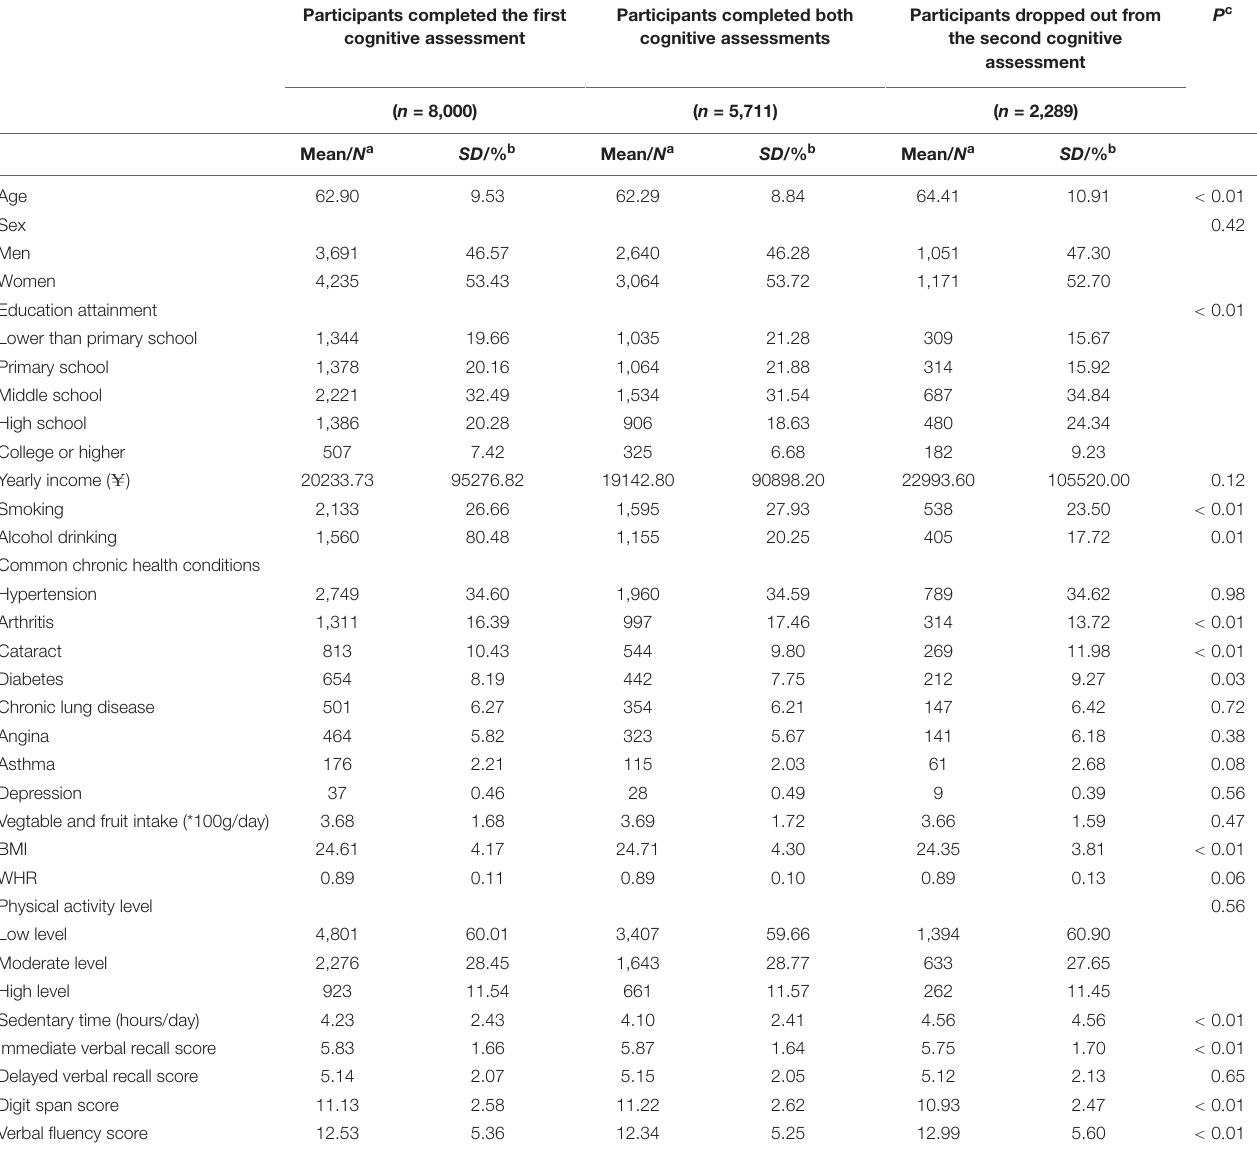
TABLE 1 | Comparisons of baseline characteristics between participants completed both cognitive assessments and those who dropped out from the second cognitive assessment. Participants completed the first Participants completed both cognitive assessment cognitive